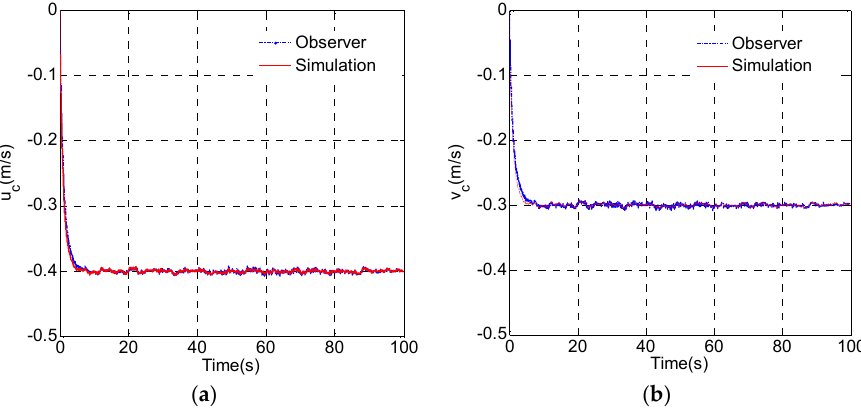
Figure 9. Observed results of current velocity: ( a ) current velocity in the X direction of earth-fixed frame; ( b ) current velocity in the Y direction of earth-fixed frame.